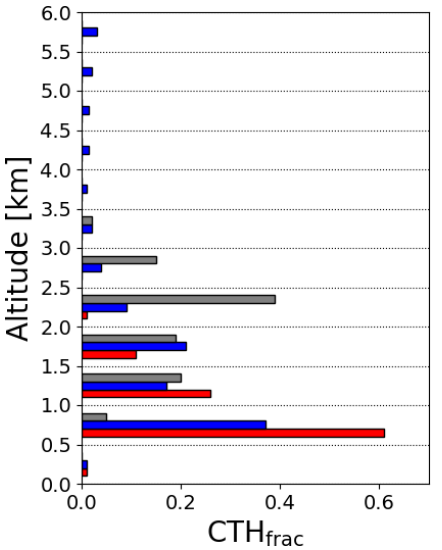
Figure 6. Histograms of detected cloud top height fractions during NARVAL-I and NARVAL-II with bins of 0.5km size. Red bars il- lustrate the distribution of cloud top height fractions in SAL regions. Blue bars represent the derived cloud top height distribution from measurements in the dust-free trades during NARVAL-II. Grey bars show the derived cloud top height in the dust-free winter season during